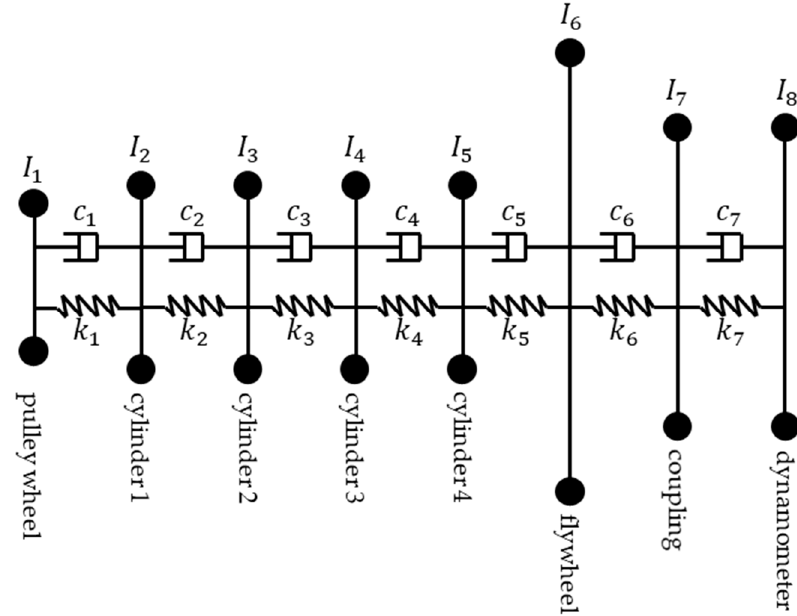
Figure 3. Schematic of the torsional model.